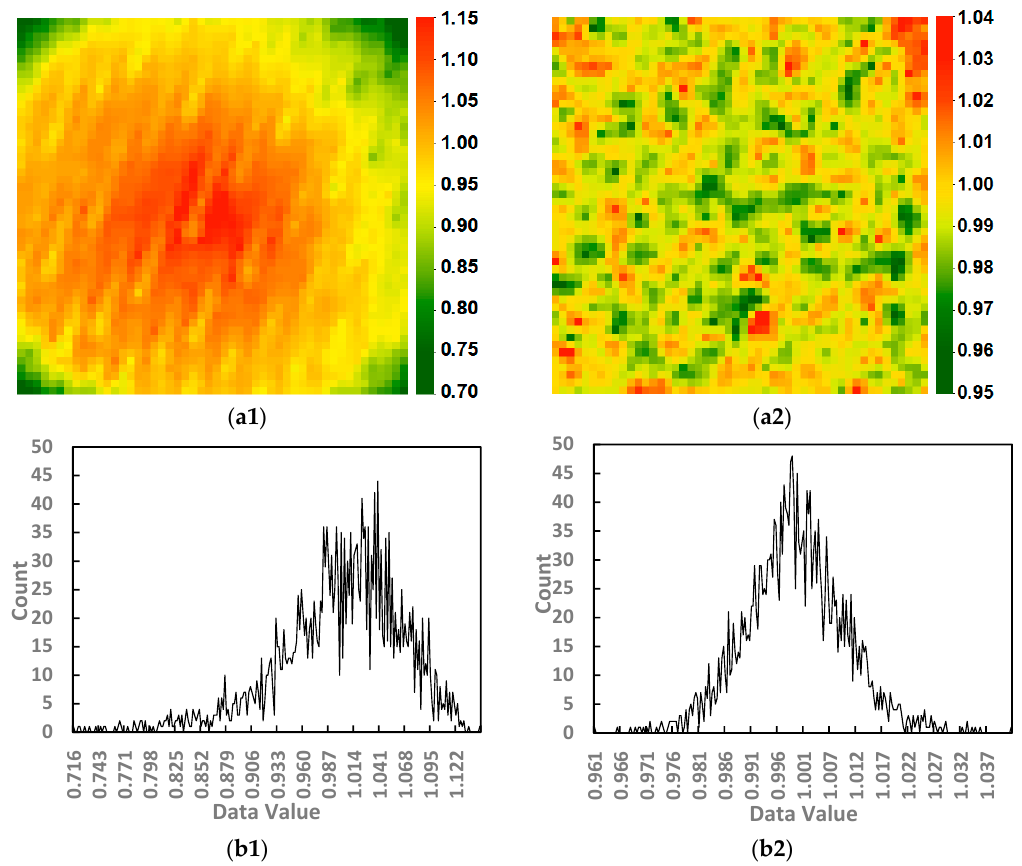
Figure 7. Radiometric response variation maps and corresponding frequency histograms for uncorrected ( a1 , b1 ) and corrected ( a2 , b2 ) images (550 nm).